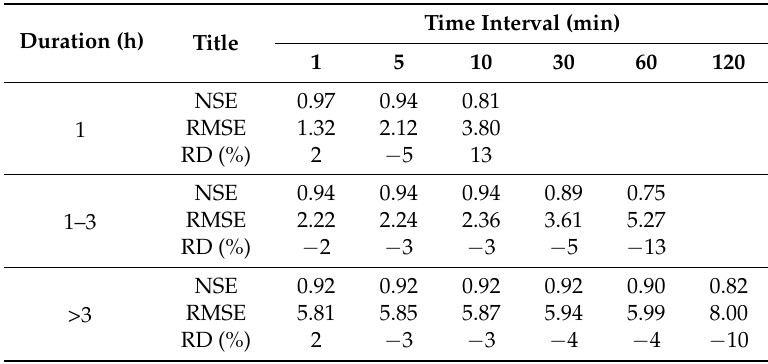
Figure 5. Percent of cumulative rainfall depth derived by the Improved Huff curves (probability 50%) using different time intervals for three groups (rainfall duration: 1 h, 1 – 3 h, and >3 h) of storms from 2008 to 2012 at Site 2. Plots ( a , c , e ) are for the rising limb, and plots ( b , d , f ) are for the falling limb. Table 7. NSE, RMSE, (mm) and Relative Difference (RD) values between design storms derived by the Improved Huff curves (probability 50%) using different time intervals and observed rainfall depth for all storms at Site 2 from 2008 to 2012.